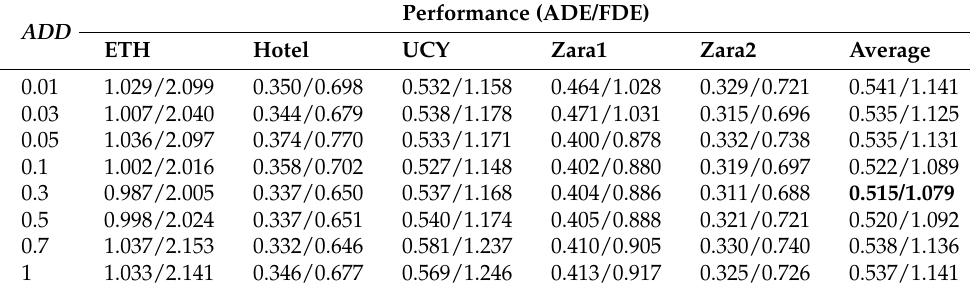
Table 6. Result comparison on ETH and UCY datasets with different Accuracy Discrimination Distance ADD. The threshold of ADD is set as 0.3 to pursue the best performance in average ADE and